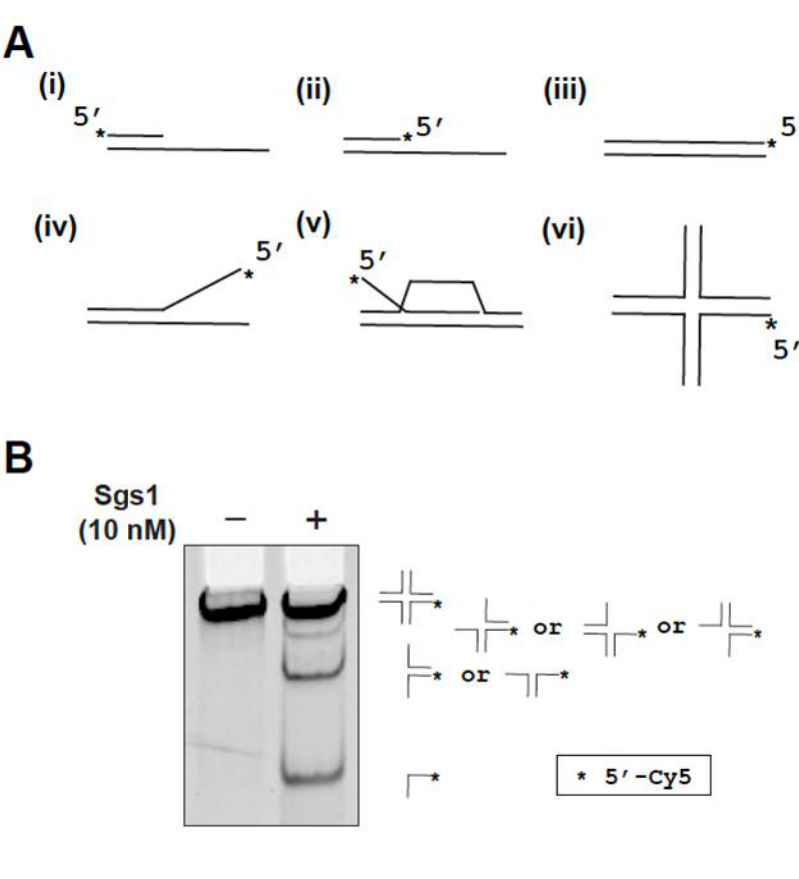
FIGURE 10: Holliday junction unwinding. (A) Diagrams of syn- thetic DNA structures frequently used in DNA helicase assays. (B) Sgs1-catalyzed unwinding of a fluorescently labeled Holliday junction